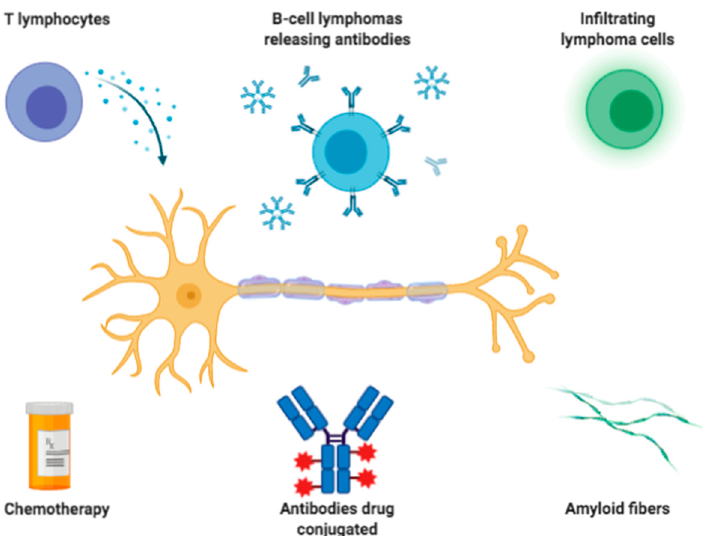
Figure 7. Main mechanisms of nerve damages of neuropathies associated with hematological dis- eases. Nerves, either myelin and/or axons, of patients with hematological diseases, might be dam- aged by cytotoxic T lymphocytes, antibodies released by neoplastic B-cell, infiltrating lymphoma cells, chemotherapy (i.e., vinca alkaloids, immunomodulating agents or protease inhibitors), anti- bodies drug-conjugated (like brentuximab vedotin) or the deposition of beta-amyloid fibers from free-light chains. Created online with